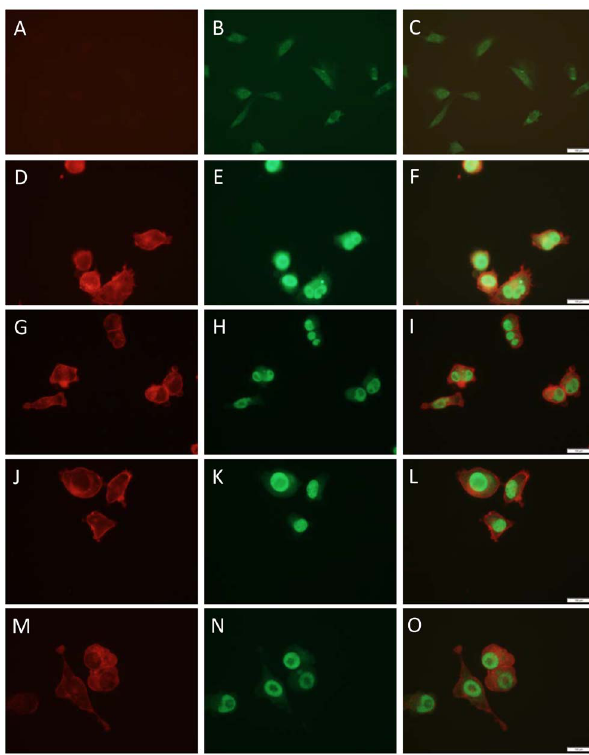
Figure 9. Localization of H-Ras and c-Myc in tumor-cell lines. Cells in chamber slides were fixed with 3.7% paraformaldehyde and permeabilized by treating with ice-cold acetone/methanol (1:1) on ice for 15 min. The slides were then washed with PBS containing 0.1% Tween 20 (0.1%PBST) three times and blocked for 1 h with 5% normal goat serum. The anti-H-Ras mouse monoclonal antibody F235 (sc-29) and the anti-c-Myc rabbit polyclonal antibody C-19 (sc-788) were used at 1:100 dilution. The antibodies were mixed and allowed to react overnight at 4 u C. The second antibodies (at 1:2500 dilution) were goat anti-mouse conjugated with Alexa Fluor 594 (for H-Ras) and goat anti- rabbit conjugated with Alexa Fluor 488 (for c-Myc). The slides were visualized using an Olympus 1 6 51 microscope fitted with fluorescence. Pictures were taken using a 40x objective, and images were over- layered using Olympus CellSens software at a sensitivity of 800 ISO with a resolution of 680 6 512 for live images and 1360 6 1024 for snap images. Panels A , B , C : NIH/3T3 cells. Panels D , E , F and G , H , I corresponded to two lines derived from tumors induced by circular ras/ myc plasmid, while panels J , K , L and M , N , O corresponded to two lines derived from tumors induced by linear ras/myc plasmid. Panels A , D , G , J , M : anti-H-Ras antibody. Panels corresponded to two lines derived from tumors induced by circular ras/myc plasmid, E , H , K , N : anti c-Myc antibody. Panels C , F , I , L , O : merged images.